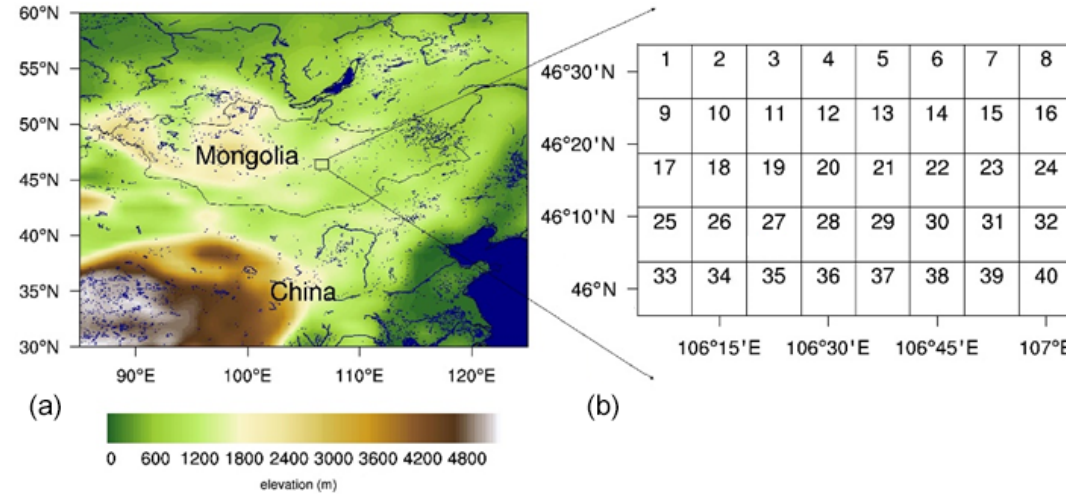
Figure 1. The topography and river distribution (a) and the geographical location of the synthetic study area (b) . Table 1. The node depths (cm) of the 10 soil layers in the CoLM model. Layer 1 2 3 4 5 6 7 8 9 10 Depth (cm) 0.7 2.8 6.2 11.9 21.2 36.6 62.0 103.8 172.8